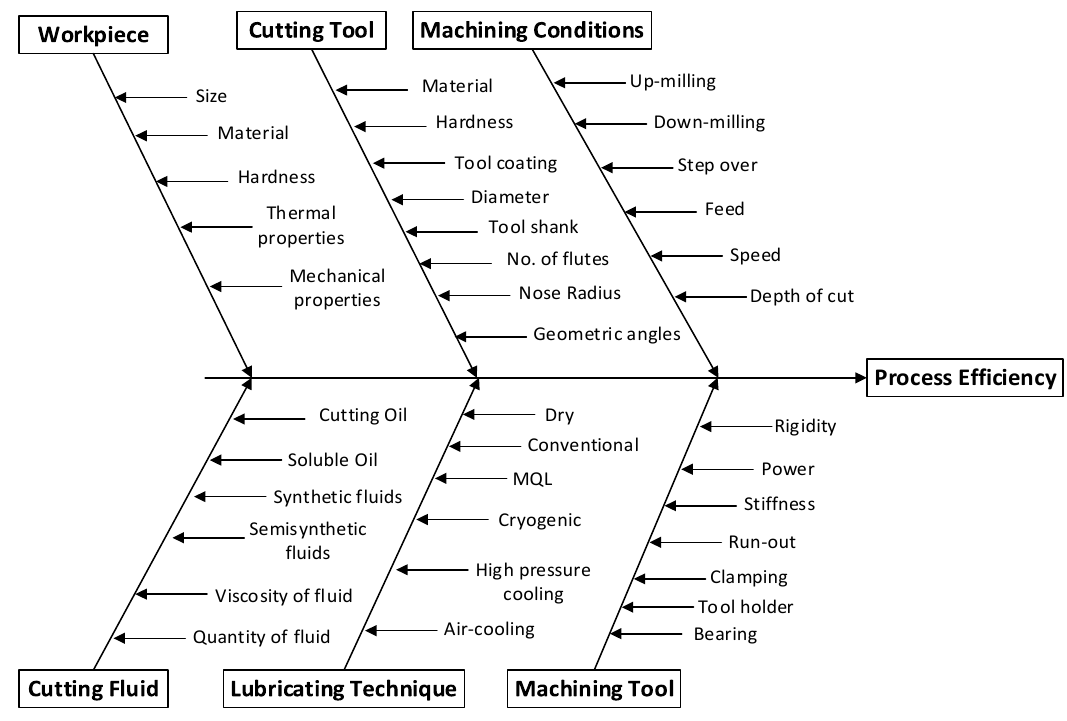
Figure 3. The effect of process parameters on process Figure 3. The e ffect of process parameters on process efficiency.